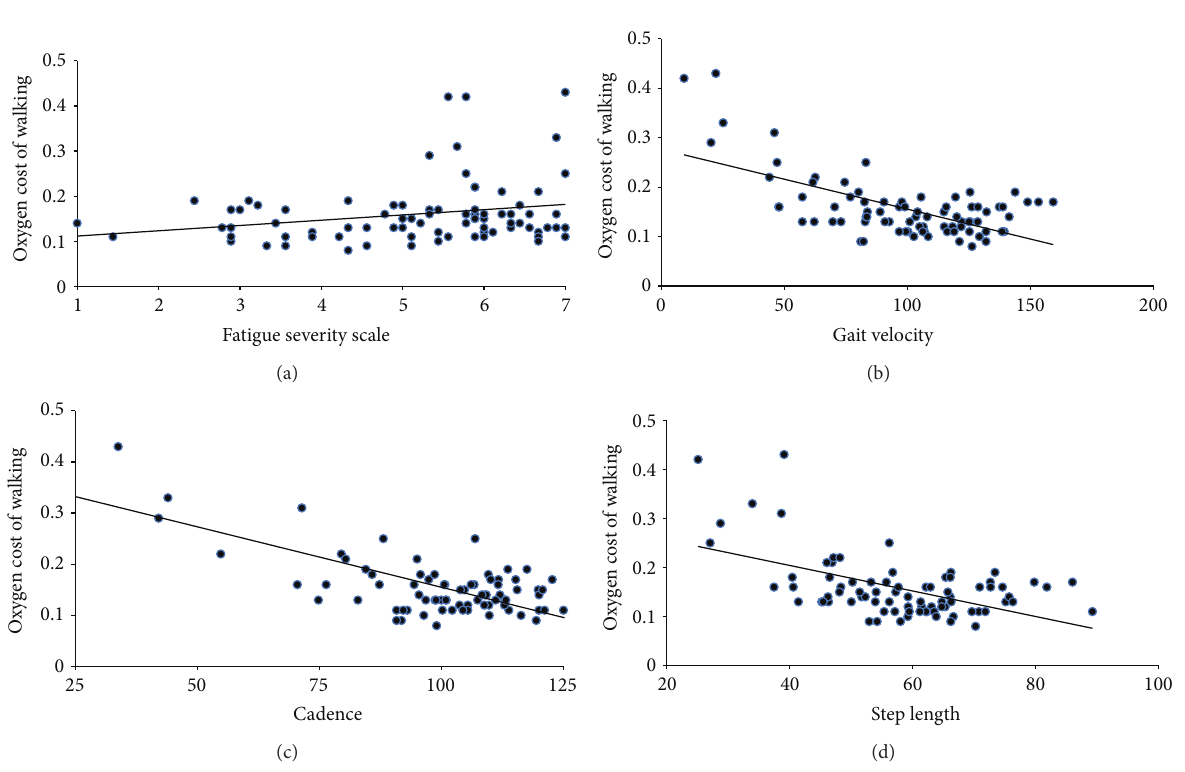
Figure 2: Scatter plots of oxygen cost of walking (mL/kg/m) and (a) fatigue, (b) gait velocity (cm/s), (c) cadence (steps/min), and (d) step length (cm) along with lines of best fit and 95% confidence intervals in 82 persons with multiple